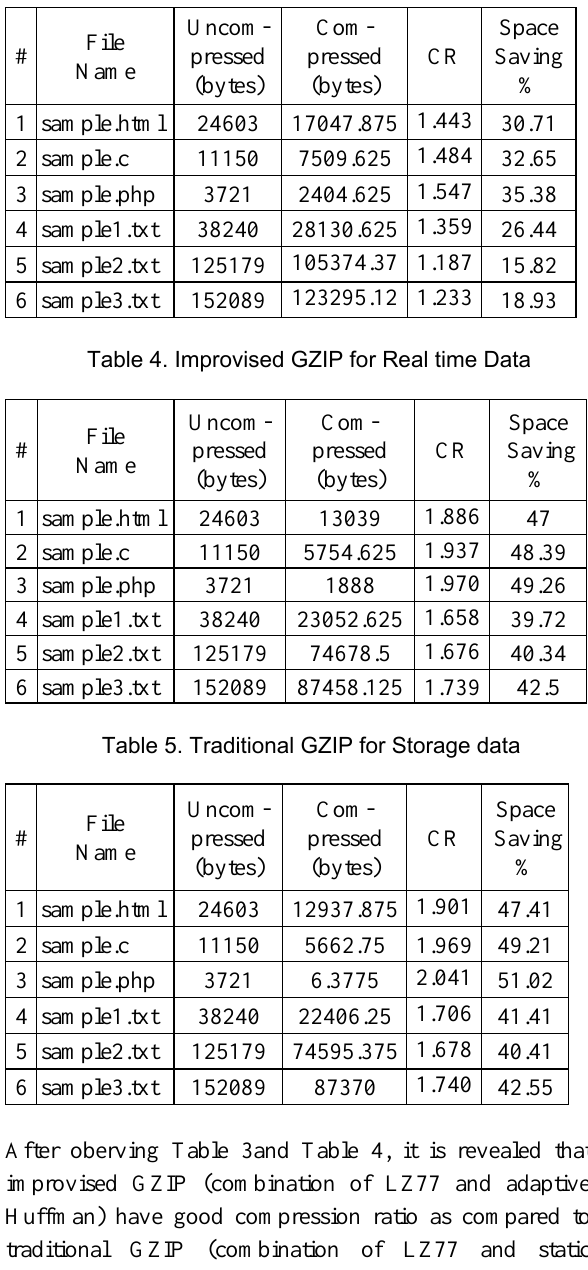
Table 3. Compression Ratio & Space Saving of GZIP